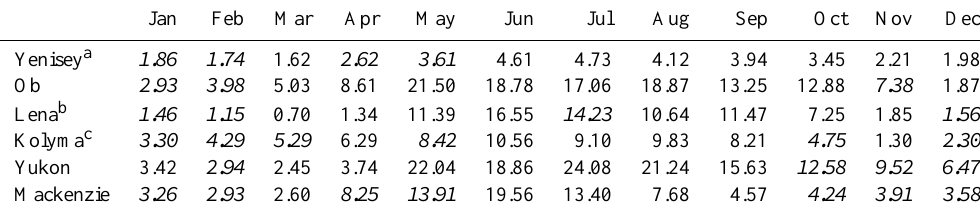
Table A6. Monthly-binned riverine concentrations of PON (mmolNm − 3 ) . Linearly interpolated values are shown in italic. Jan